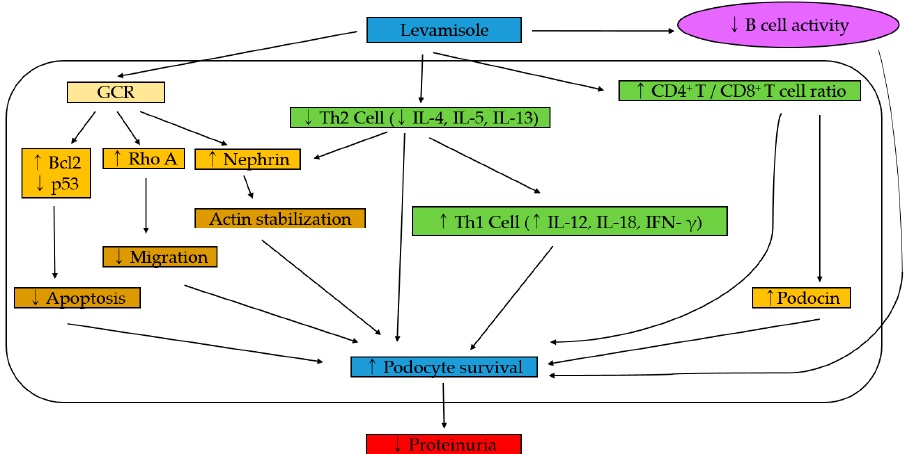
Figure 1. The summary effects of levamisole in iNS. Bcl2: B-cell lymphoma 2, CD: Cluster of differentiation, IFN- γ : interferon gamma, IL: interleukin, iNS: idiopathic nephrotic syndrome, GCR: glucocorticoid receptor, p53: tumor protein p53, Th Cell: The T helper cells.